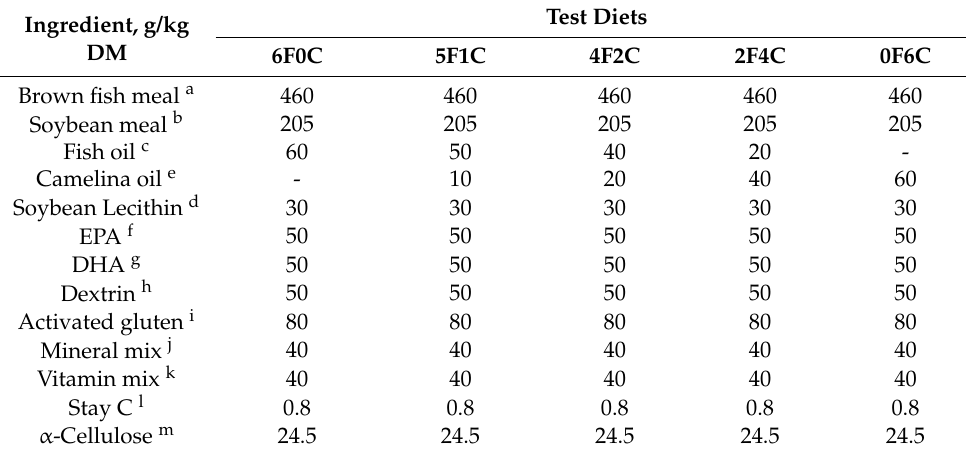
Table 1. Experimental diets formulation and proximate